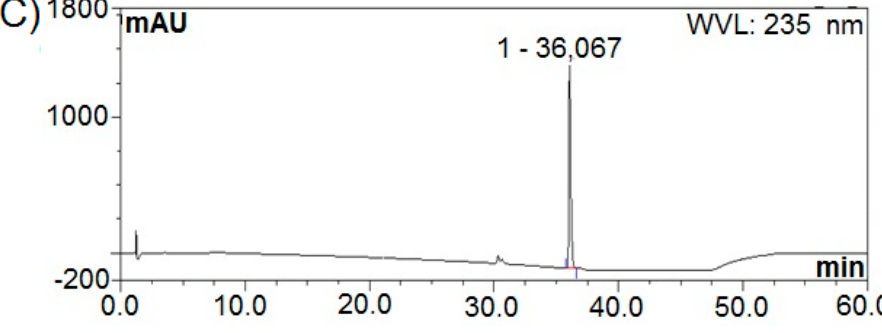
Figure 5. HPLC patterns; ( A ) NT-5, ( B ) NT-6 and ( C ) NT-7.